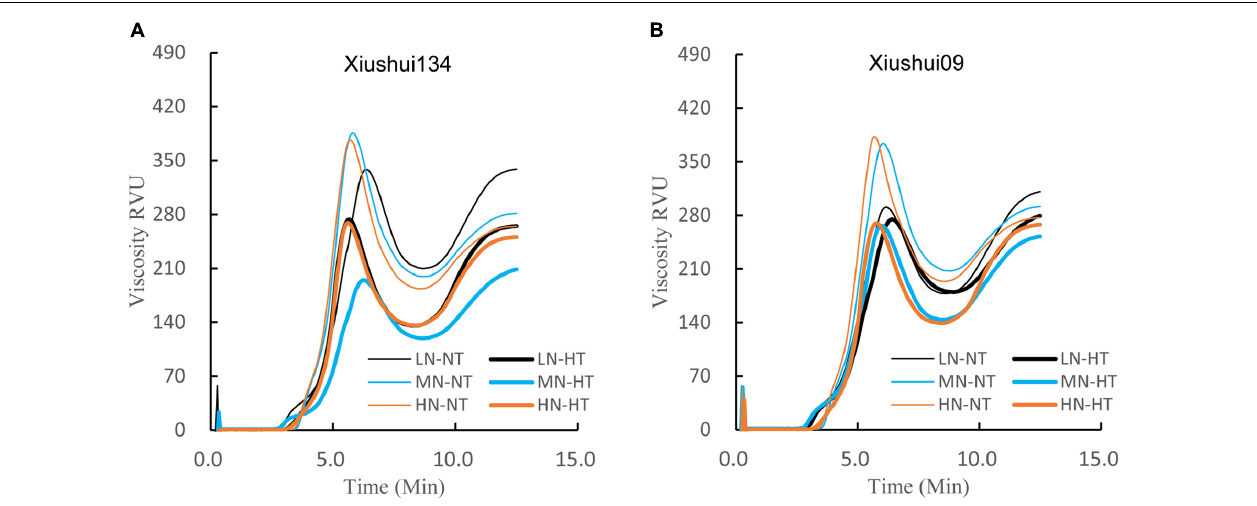
FIGURE 5 | Comparison of RVA profile for different nitrogen-temperature treatments. LN-NT, MN-NT, HN-NT, LN-HT, MN-NT, and HN-HT indicate low nitrogen-normal temperature, moderate nitrogen-normal temperature, high nitrogen-normal temperature, low nitrogen-high temperature, moderate nitrogen-high temperature, and high nitrogen-high temperature, respectively. (A) RVA profile of Xiushui134; (B) RVA profile of